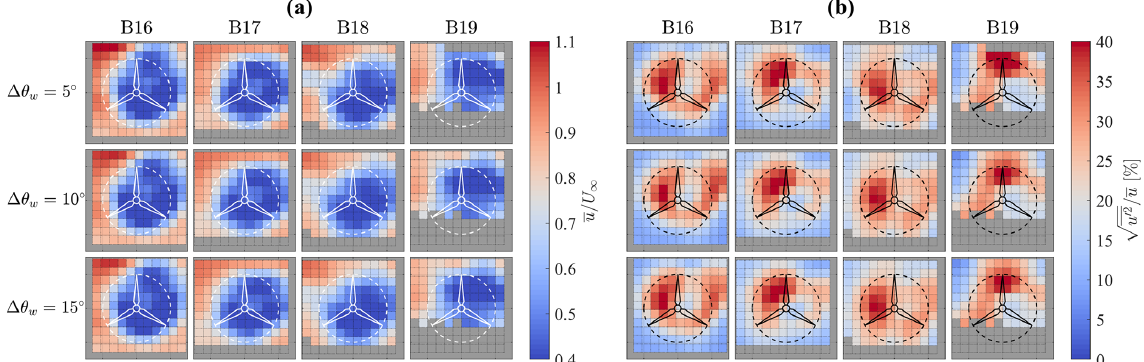
Figure 13. Fields reconstructed adopting several (cid:49)θ w values and sampled at x/D ∼ 1 . 3 downstream of turbines B16, B17, B18, and B19. (a) Mean streamwise velocity and (b) streamwise turbulence intensity.